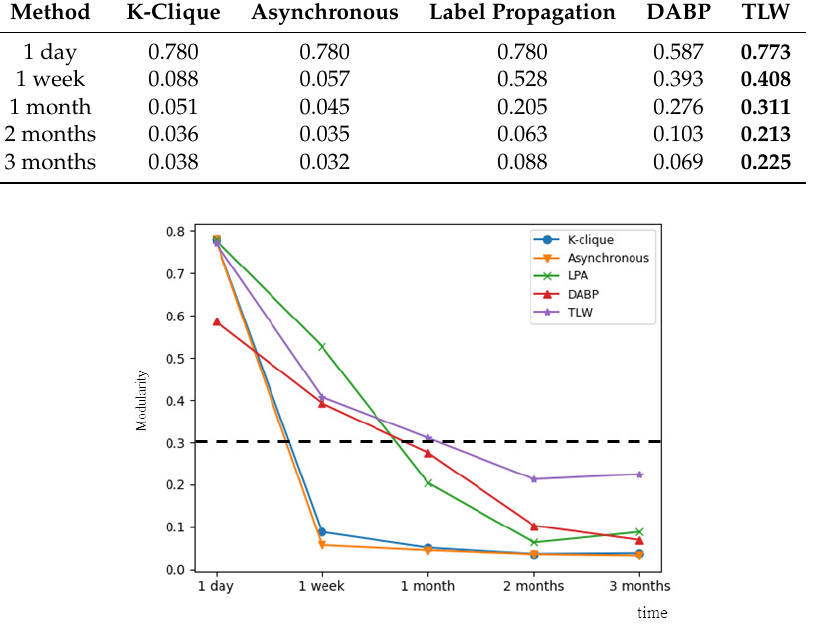
Figure 8. Modularity of different methods from one day to three months.